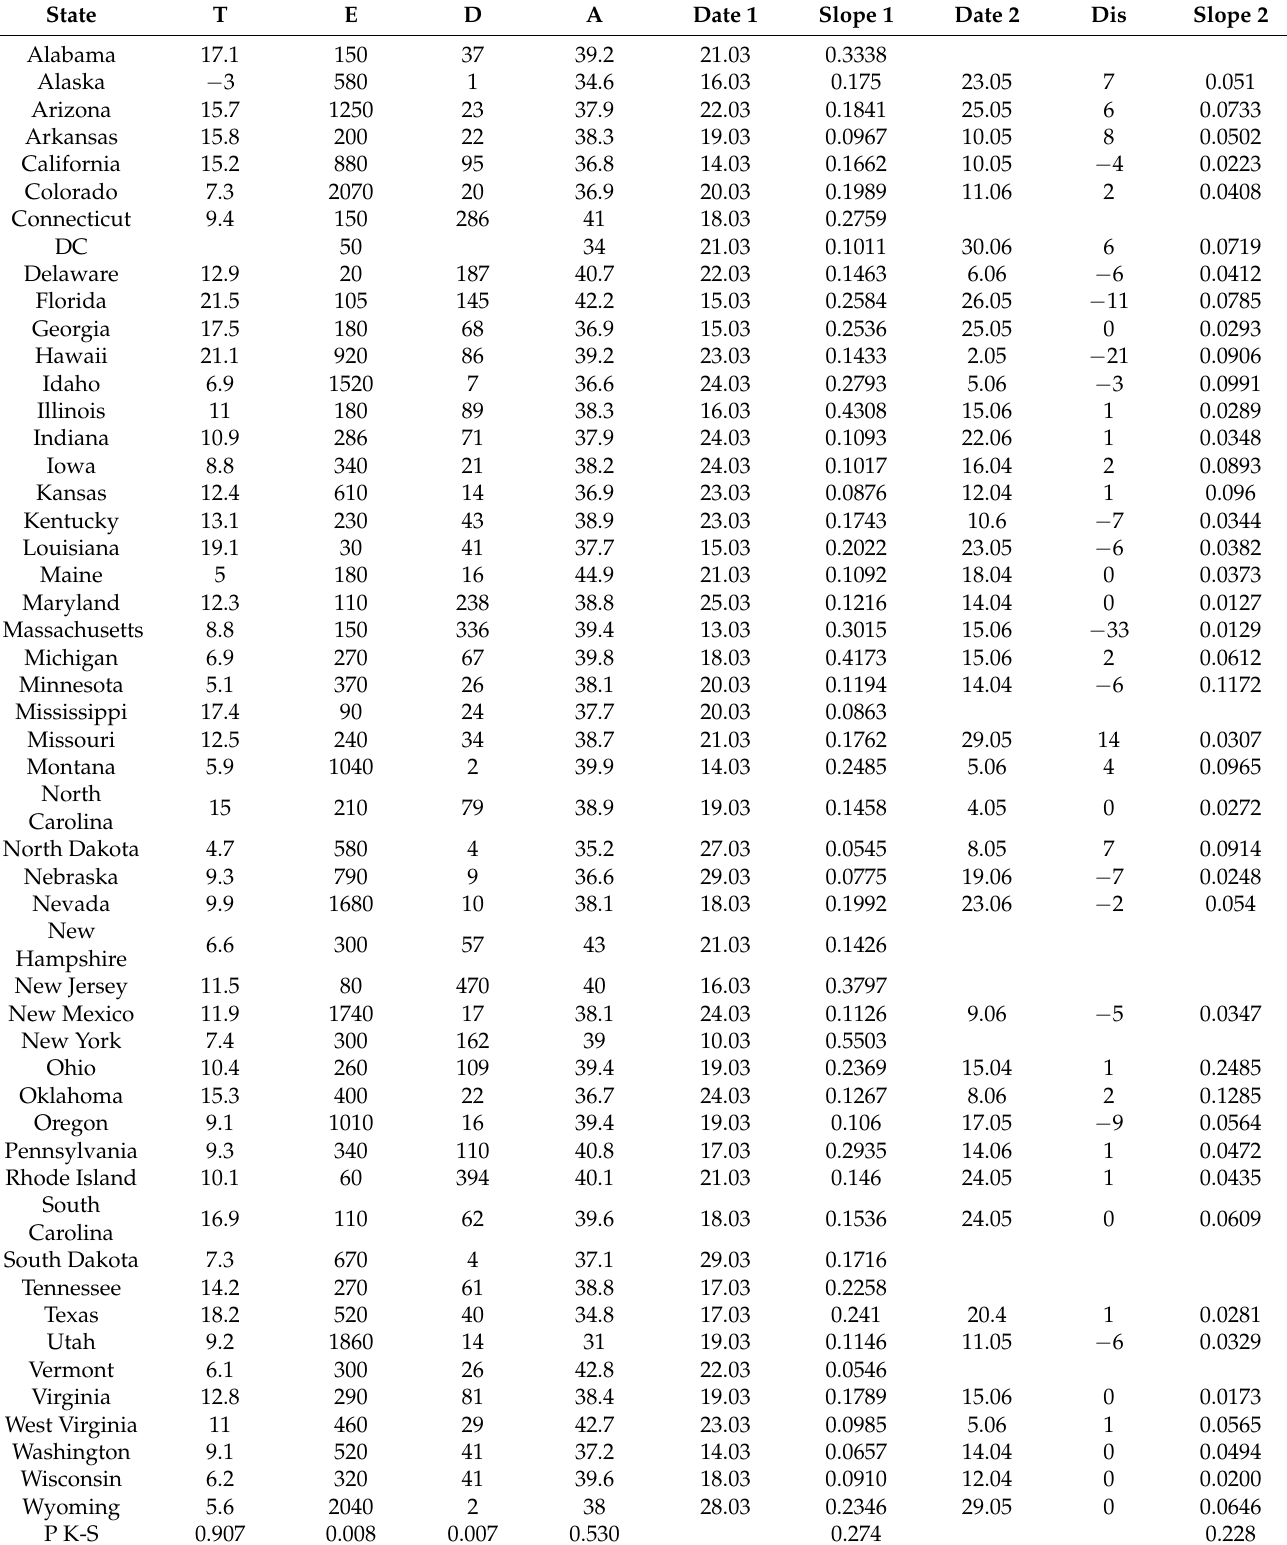
Table 2. Spread parameters of first and second waves in the 50 states of the USA and the district of